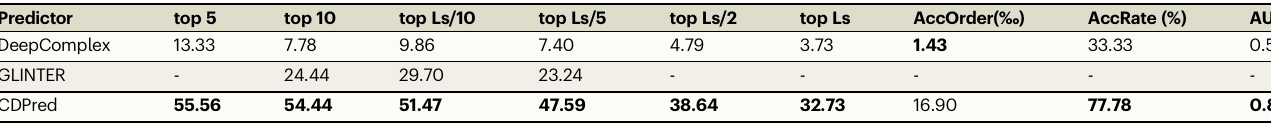
Table 3 | The evaluation of contact predictions on the HeteroTest1 test dataset for the DeepComplex, GLINTER, and CDPred Predictor